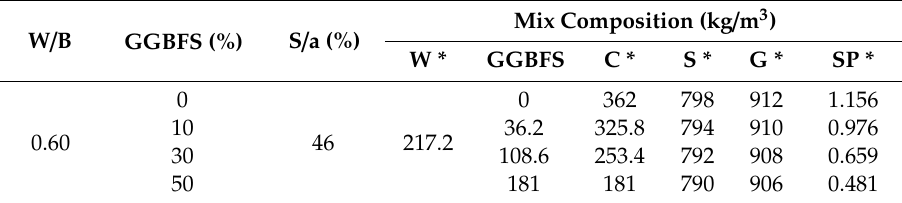
Table 3. Concrete mixture